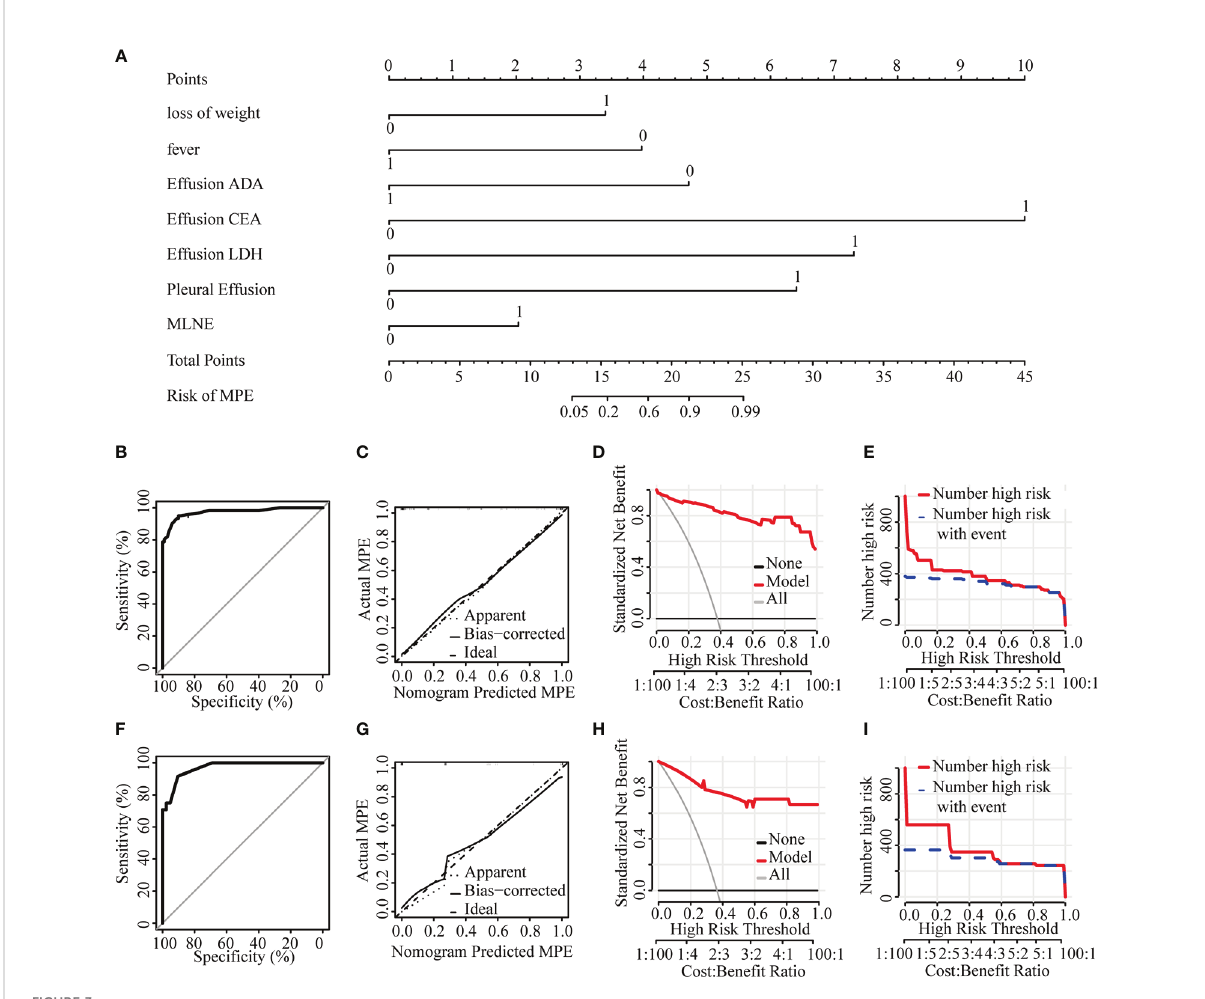
FIGURE 3 Diagnostic model of the discrimination for MPE and BPE. (A) Nomogram for identifying MPE from BPE. (B) ROC curve in the training set. (C) Calibration curve in the training set. (D) Clinical decision curve in the training set. (E) Clinical impact curve in the training set. (F) ROC curve in the validation set. (G) Calibration curve in the validation set. (H) Clinical decision curve in the validation set. (I) Clinical impact curve in the validation set. ADA, adenosine deaminase; CEA, carcino embryonic antigen; LDH, lactate dehydrogenase; MPE, malignant pericardial effusion; MLNE, mediastinal lymph node enlargement.